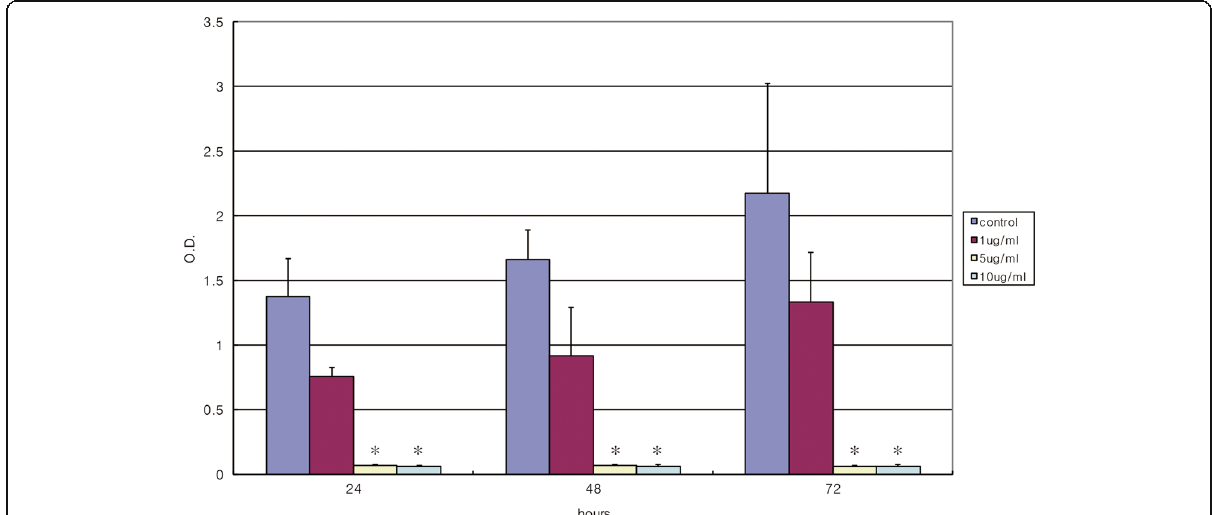
Fig. 2 The results of the MTT assay. The cell proliferation assay and the inhibition of respiratory activity. The results of the MTT assay showed a significant decrease in viable cell number in SCC-9 (* P < 0.05 compared to